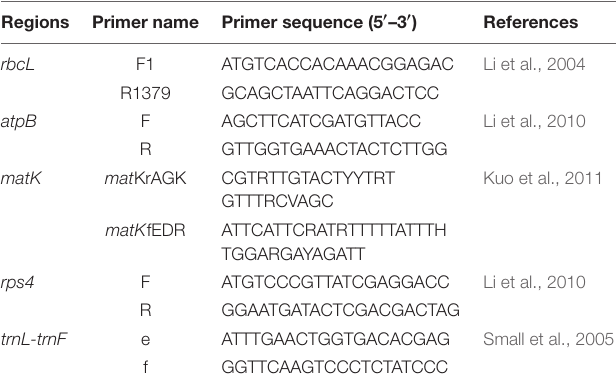
TABLE 1 | List of PCR amplification and sequencing primers used in the